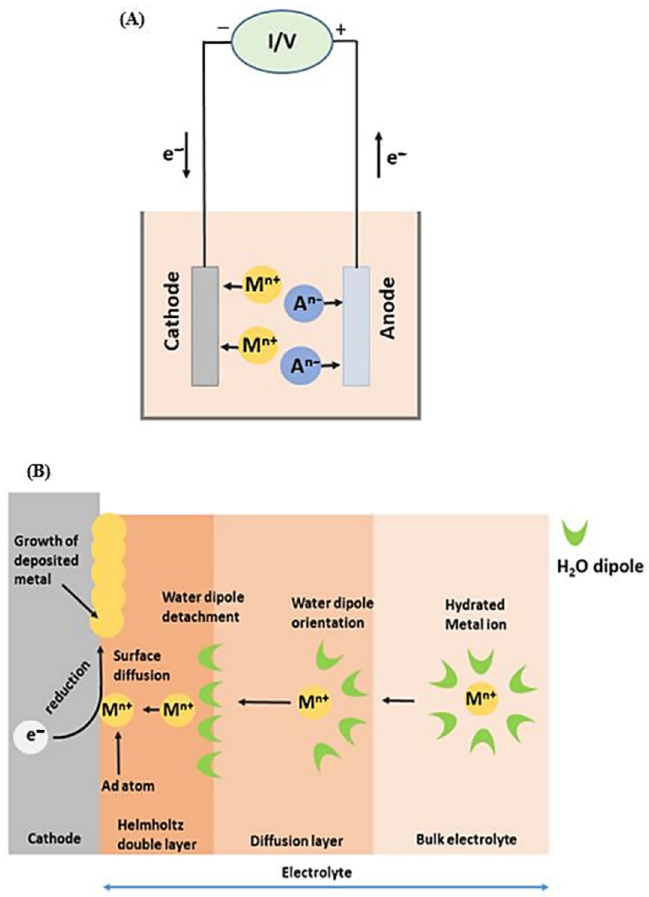
Figure 2. Schematic representation of electrodeposition process ( A ) and mechanism details ( B